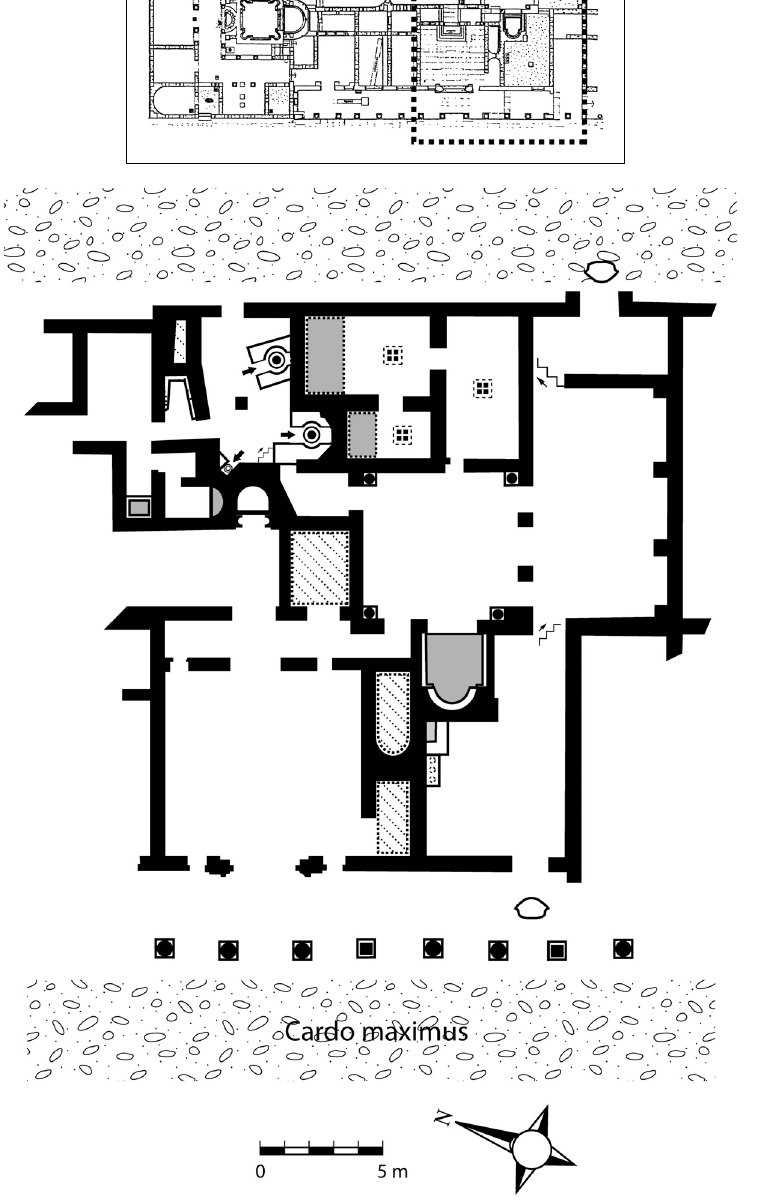
Figure 2: The baths of the House of Europe in Cuicul (after Blanchard-Lemée 1975: fi g.